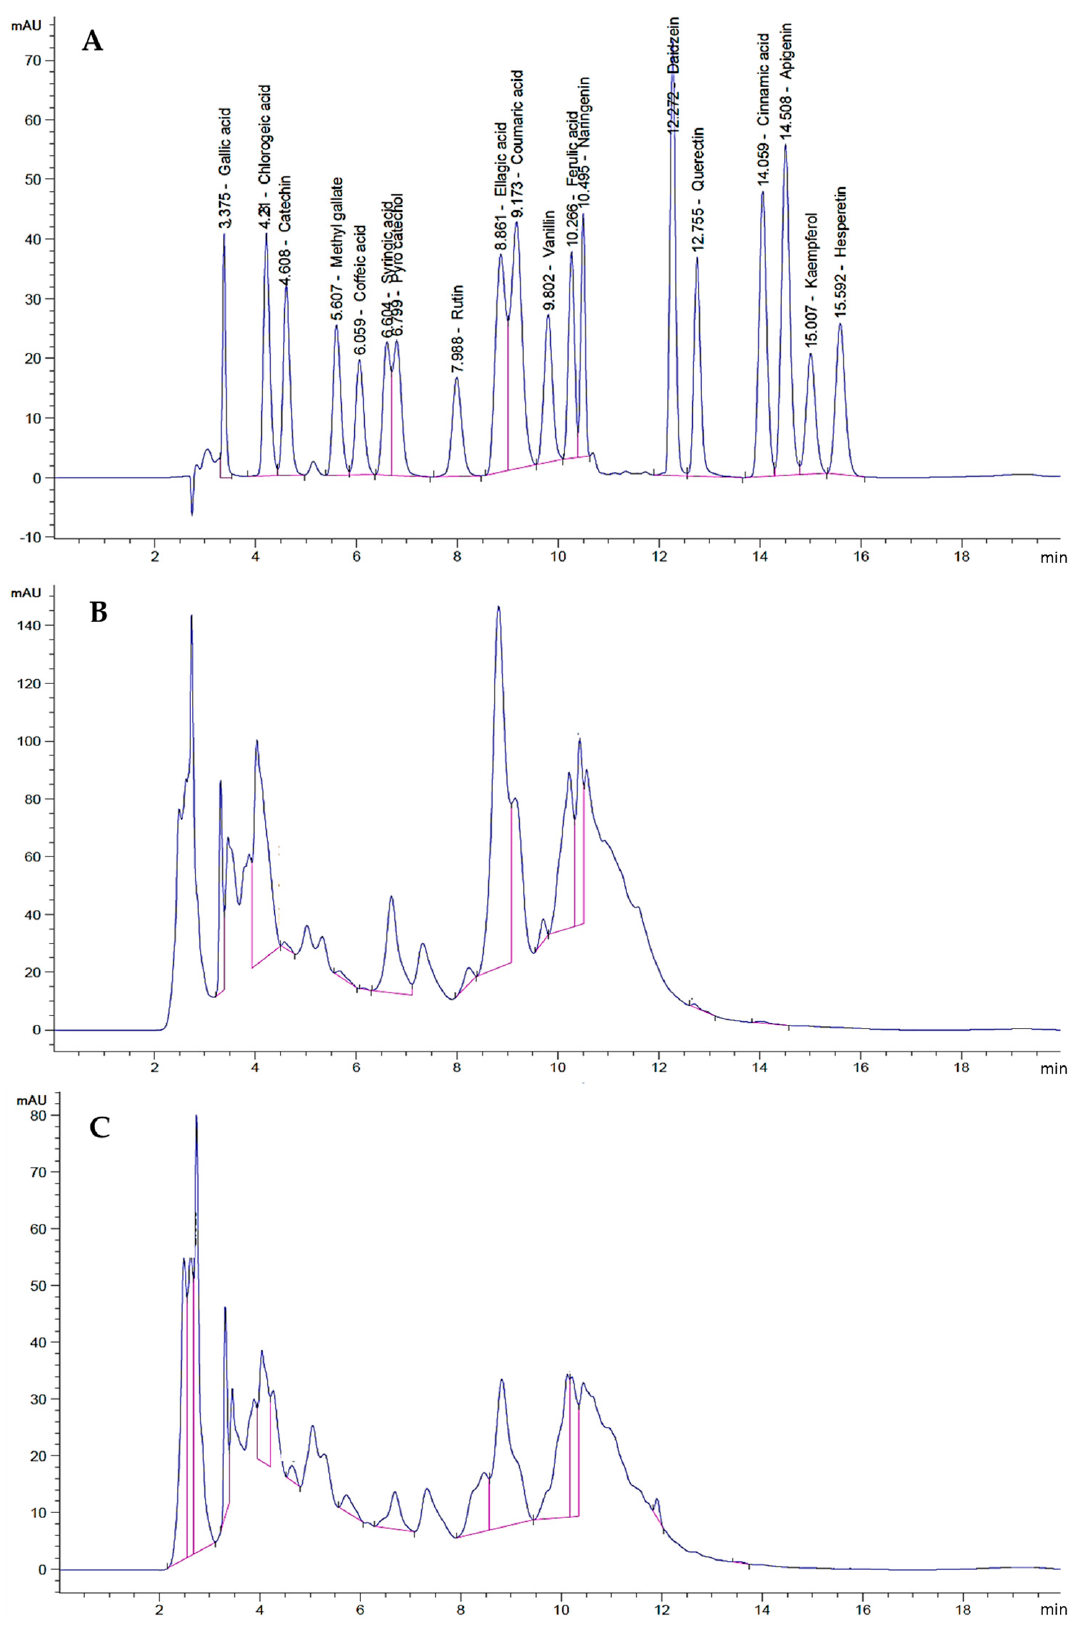
Figure 3. The HPLC chromatogram of methanol extract from Calystegia silvatica : ( A ) standard chromatogram; ( B ) leaves chromatogram; ( C ) stems chromatogram.